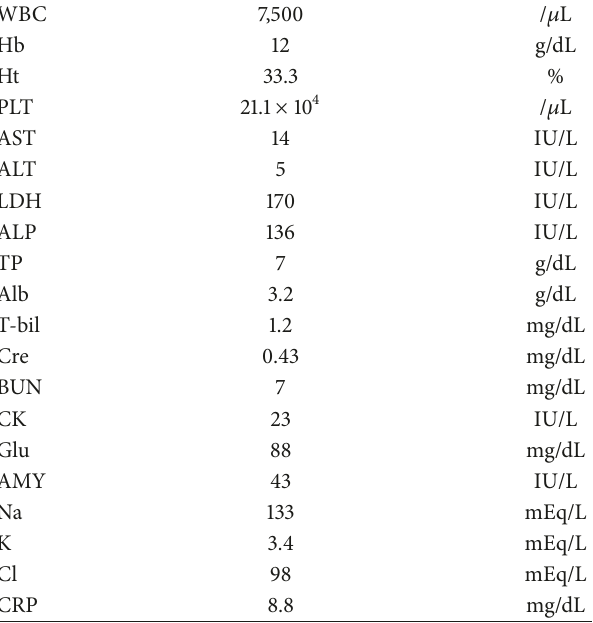
Table 1: The laboratory data of the